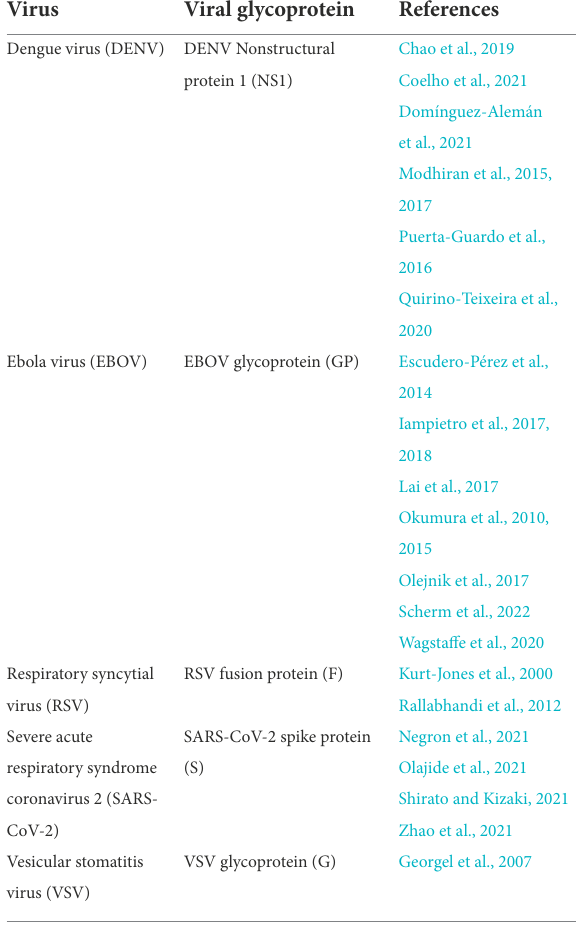
TABLE 1 Viral glycoproteins capable of TLR4